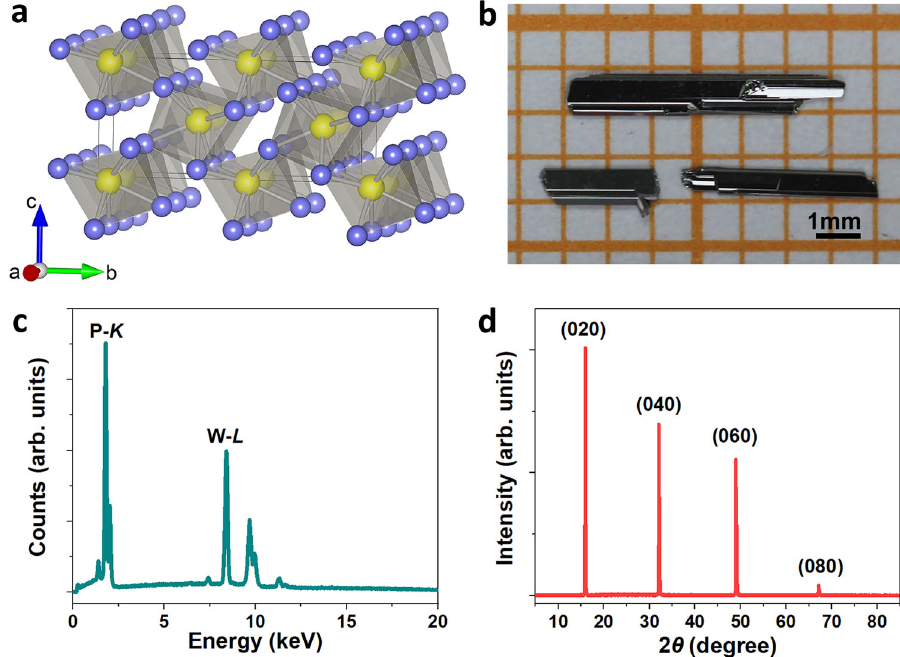
Fig. 1 Structure and composition information of β -WP 2 . a Crystal structure of β -WP 2 . b Typical photograph of the as-grown β -WP 2 single crystals. c EDS data of the β -WP 2 single crystal. d Corresponding XRD patterns of a representative single crystal.